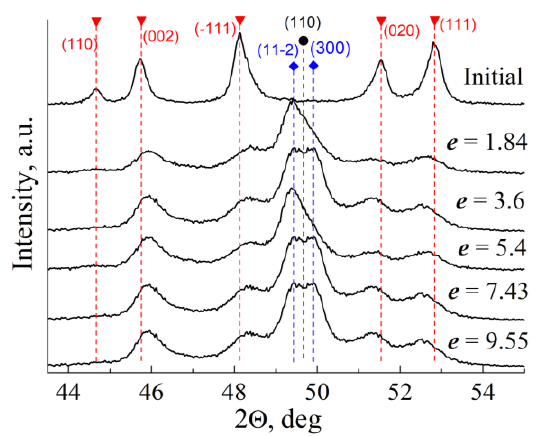
Figure 2. Fragments of XRD spectra of Ti 49.8 Ni 50.2 at room temperature (Co- Kα radiation) after abc pressing to different true strains: ▼ — B19 ’, ♦ — R, and ●— B2.